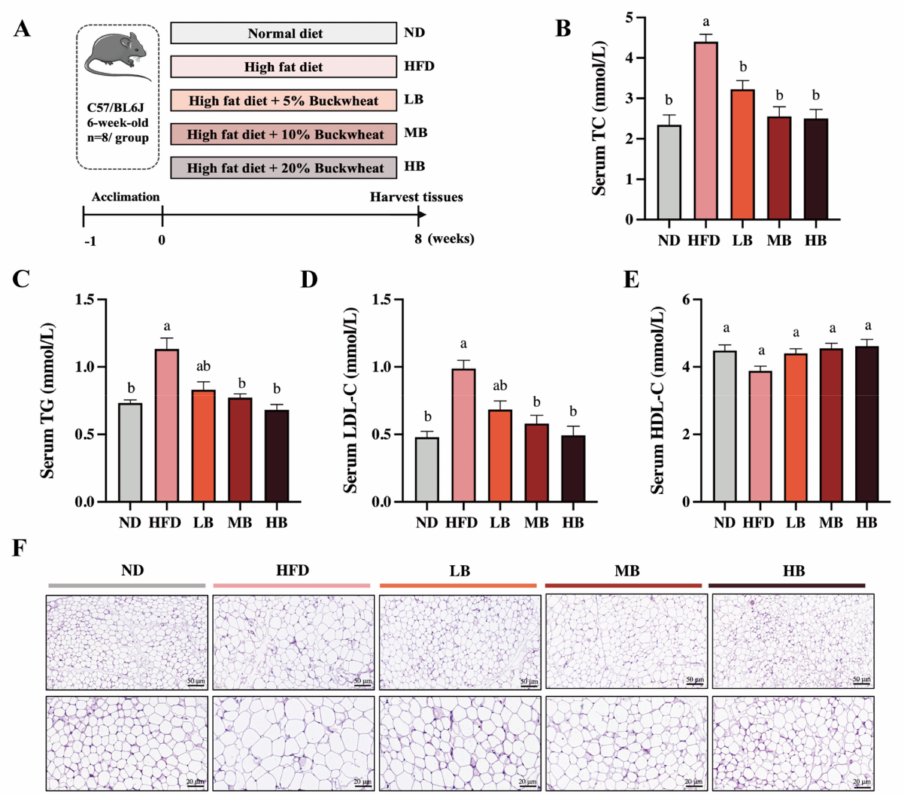
Figure 1. Effects of tartary buckwheat on HFD-induced dyslipidemia and lipid accumulation. ( A ) Flow chart of the animal experiment. ( B ) Serum TC levels. ( C ) Serum TG levels. ( D ) Serum LDL-C levels. ( E ) Serum HDL-C levels. ( F ) H&E staining of epididymis adipose (scale bar, 50 µ m and 20 µ m). Data are expressed as the mean ± SEM ( n = 8). The mean value with different letters indicates significant differences ( p <